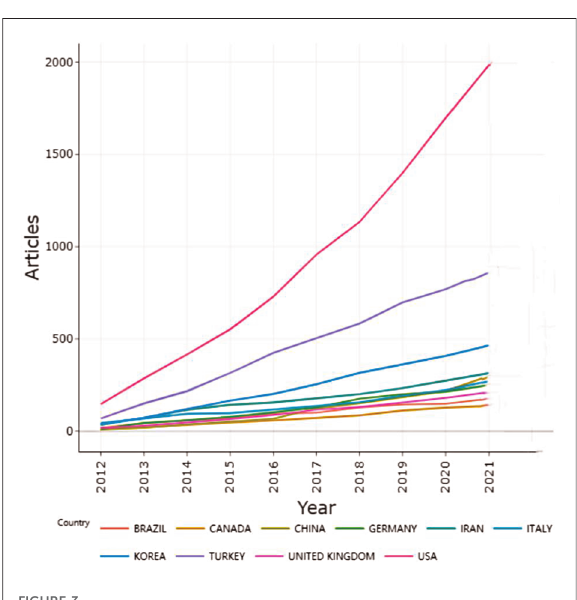
FIGURE 3 Publication status of the top 10 countries in RP research from 2012 to